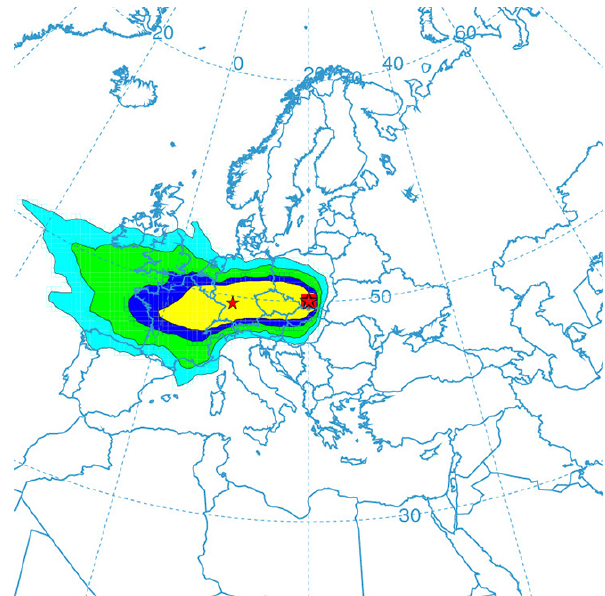
Figure 9. Spatial distribution of 96h backward trajectories of the air masses arriving in Krakow, southern Poland, which passed Heidel- berg, southern Germany, at the distance of less than 100km, calcu- lated using the HYSPLIT model (Draxler and Rolph, 2011; Rolph, 2011 – see text for details). The analysis comprised the period from January 2005 till December